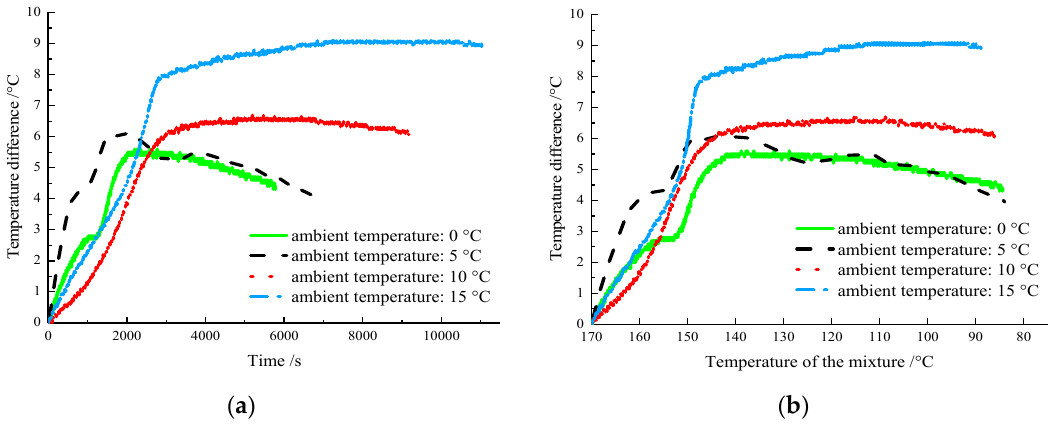
Figure 6. Variation of the temperature difference between the centers of the two samples at different ambient temperatures: ( a ) relationship between temperature difference and time; ( b ) relationship between temperature difference and temperature.